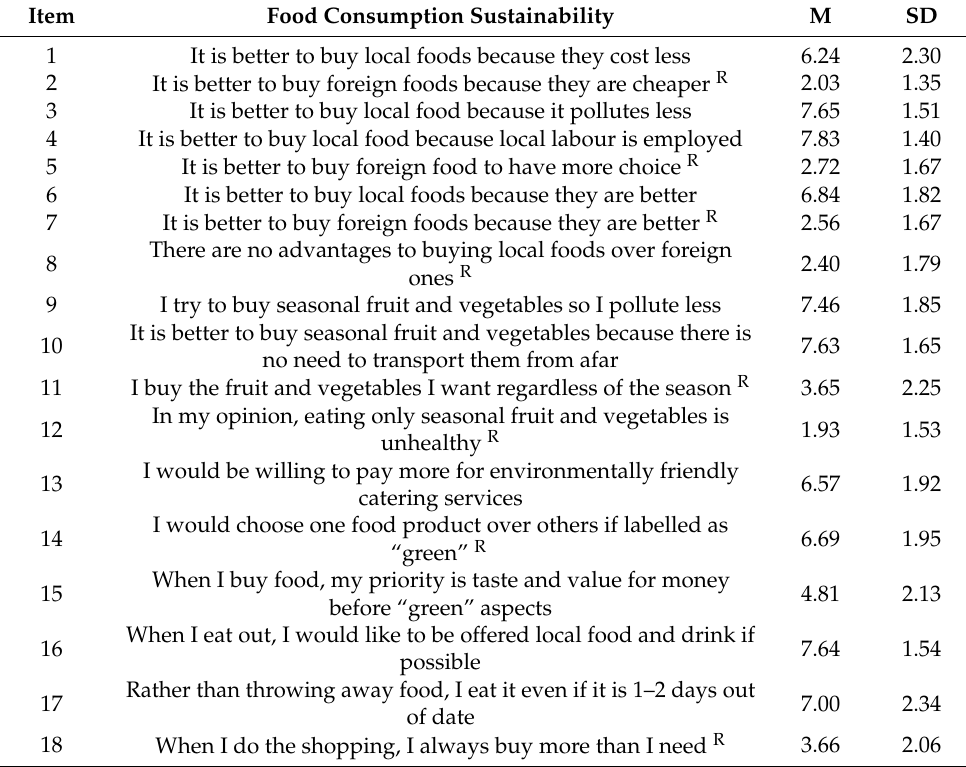
Table 2. Mean (M) and Standard Deviation (SD) values for each statement of the Food Consumption Sustainability